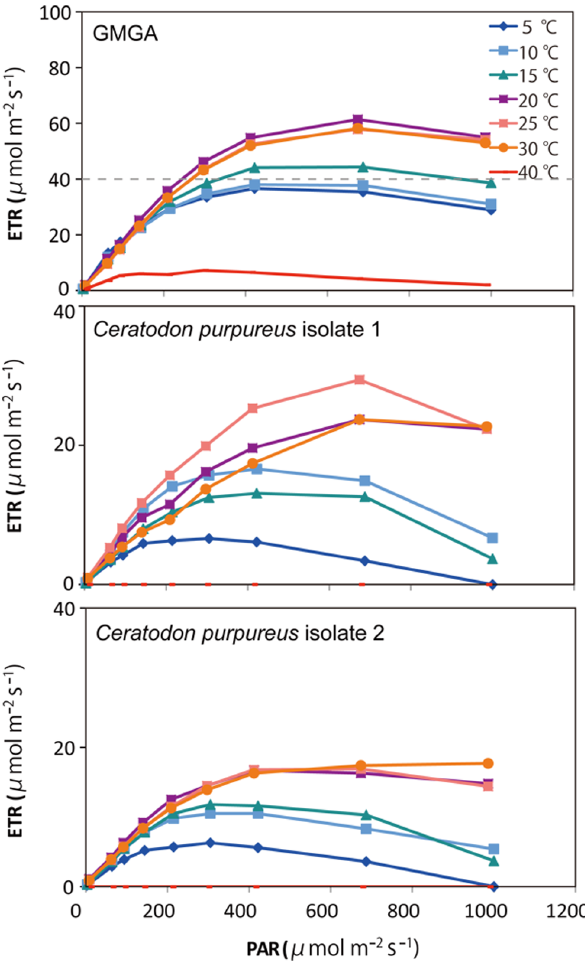
Figure 6. Photosynthetic light curves of GMGA and the two isolates under different incubation temperatures (from 5 u C to